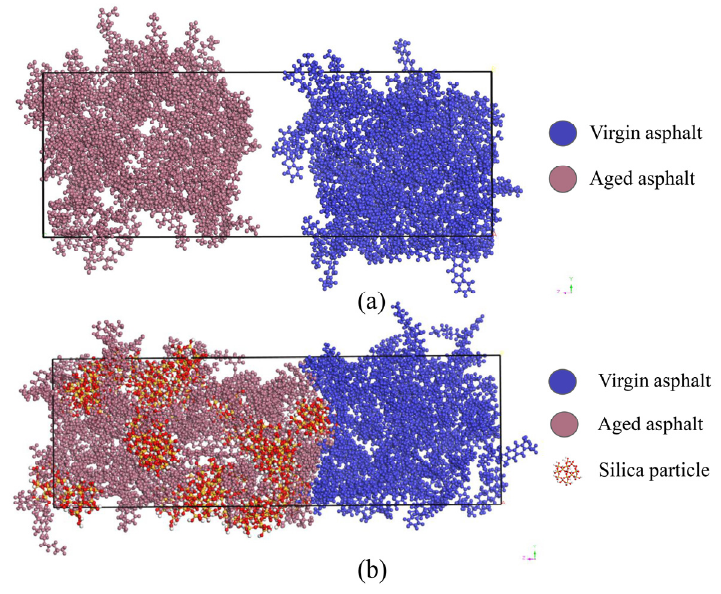
Figure 4. Mutual di ff usion model: ( a ) virgin–aged asphalt; ( b ) virgin asphalt–RAM. Figure 4. Mutual diffusion model: ( a ) virgin–aged asphalt; ( b ) virgin